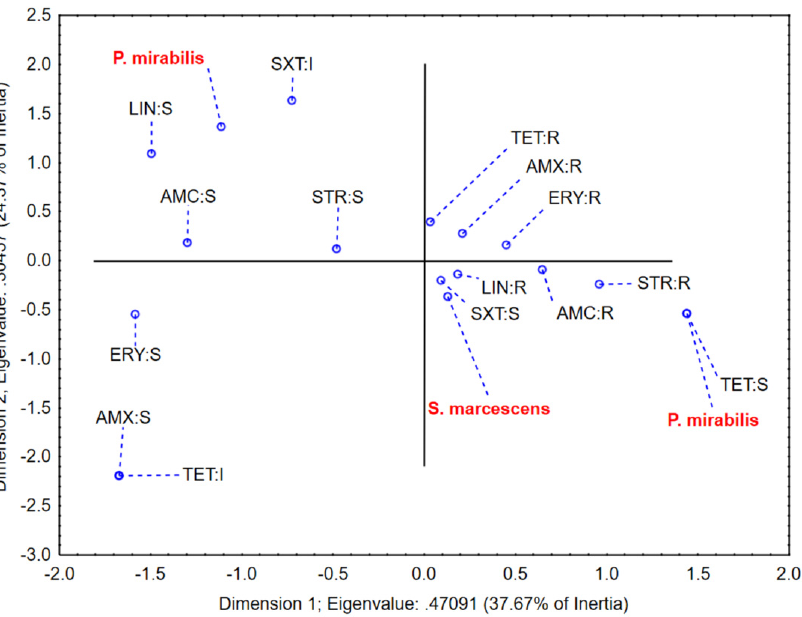
Figure 2. The position of the evaluated variables in the space defined by the first two correspondent axes. To evaluate the antimicrobial activity of selected EOs against P. mirabilis and S. marcescens strains, the determinations of minimum inhibitory concentrations (MICs) and minimal